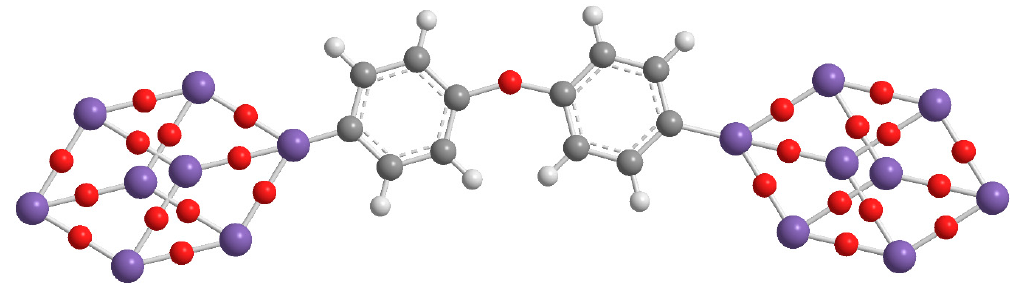
Figure 2. Molecular structure of double-cages POSS molecule.